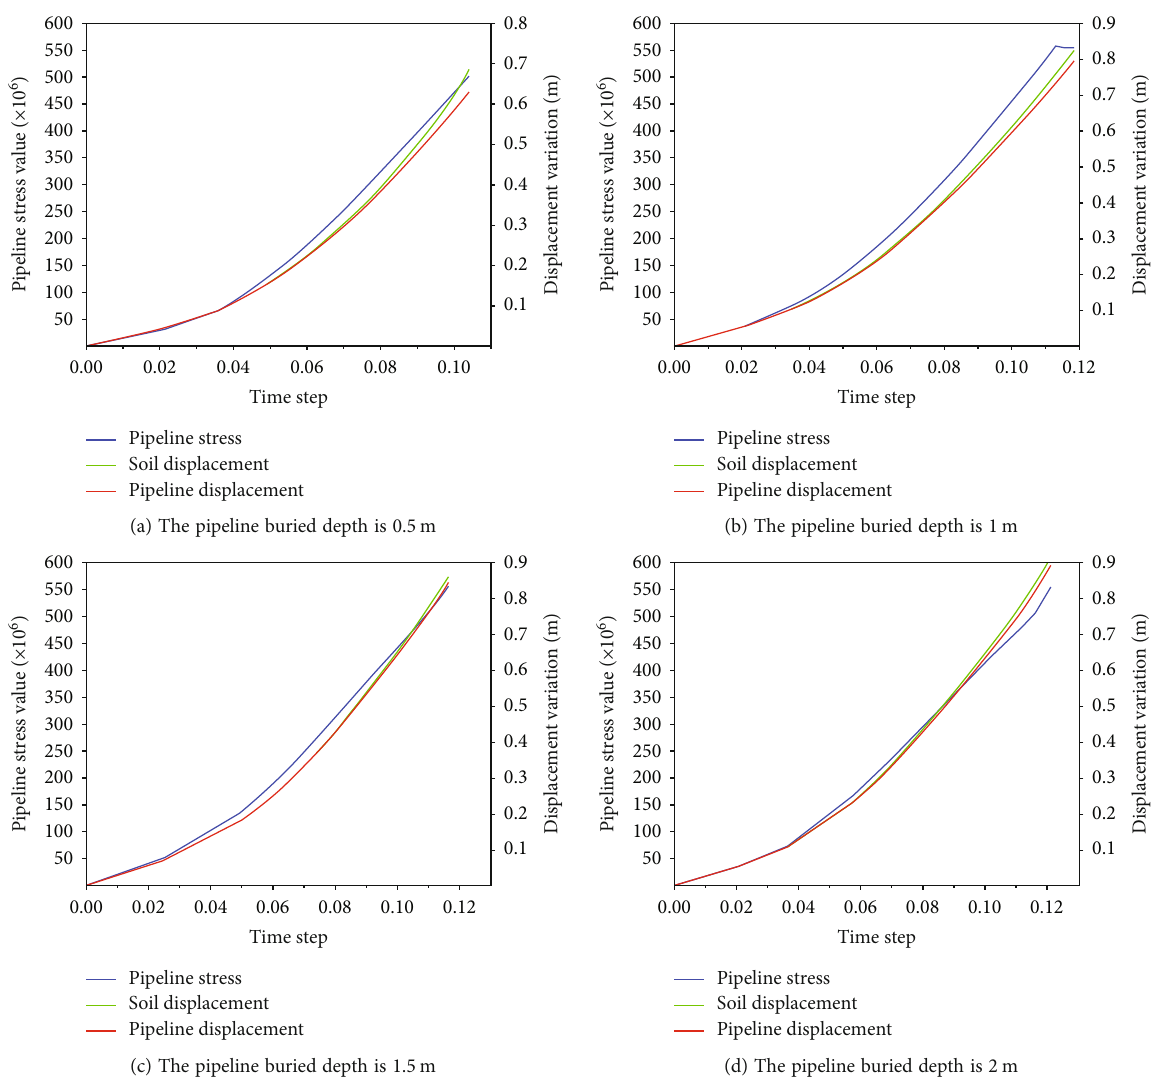
Figure 27: The diagrams of pipeline stress, displacement, and soil displacement under di ff erent pipeline buried